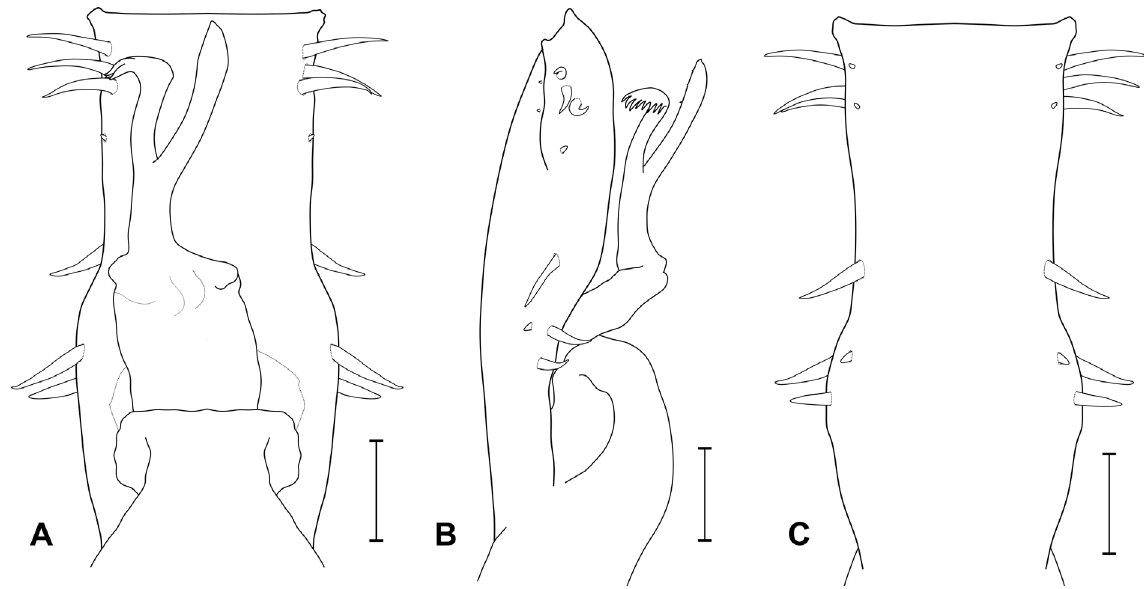
Fig. 13. Lacronia nigra (B. Soares, 1942) comb. nov., ♂ (MNRJ 9207 ꜝ ), penis, distal part. A . Dorsal view. B . Lateral view. C . Ventral view. Scale bars = 20